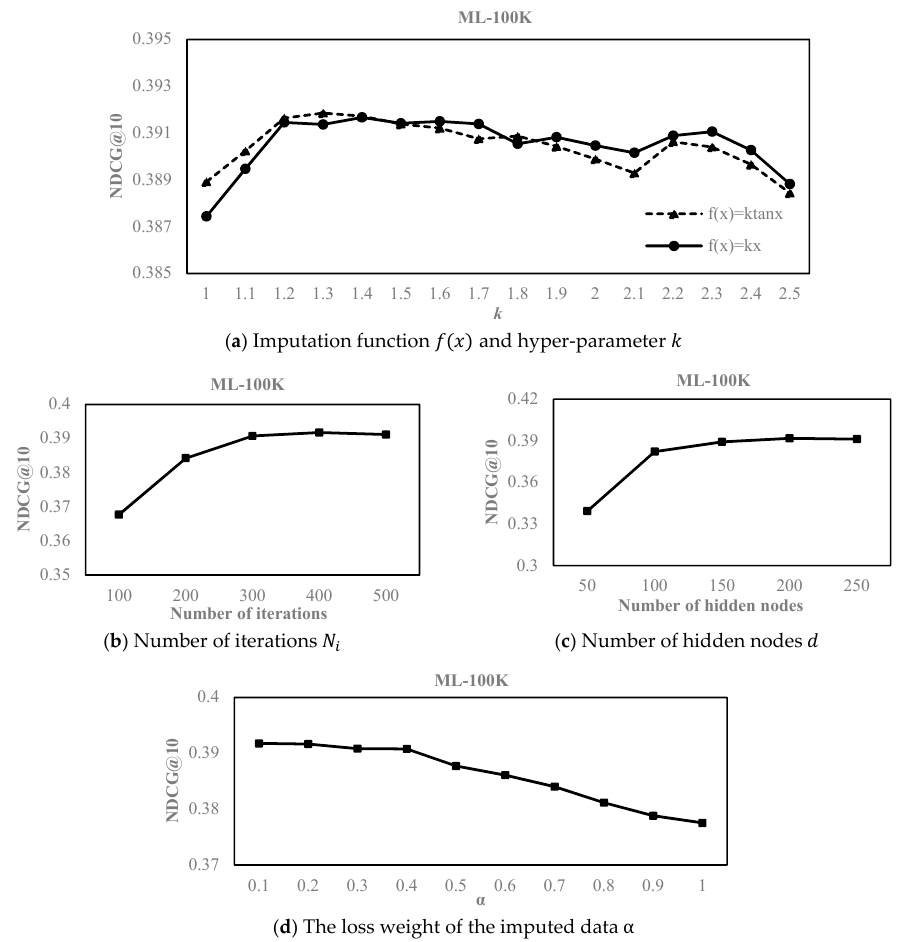
Figure 4. Performance of various parameters in CIDAE.